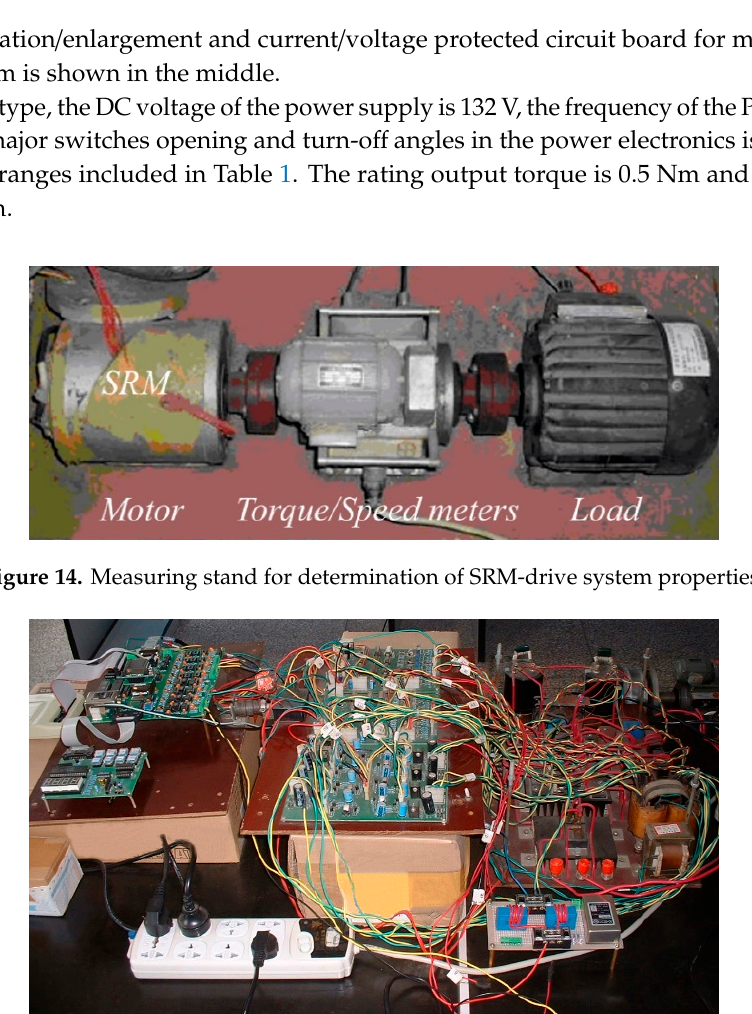
Figure 15. Power converter with the controller.